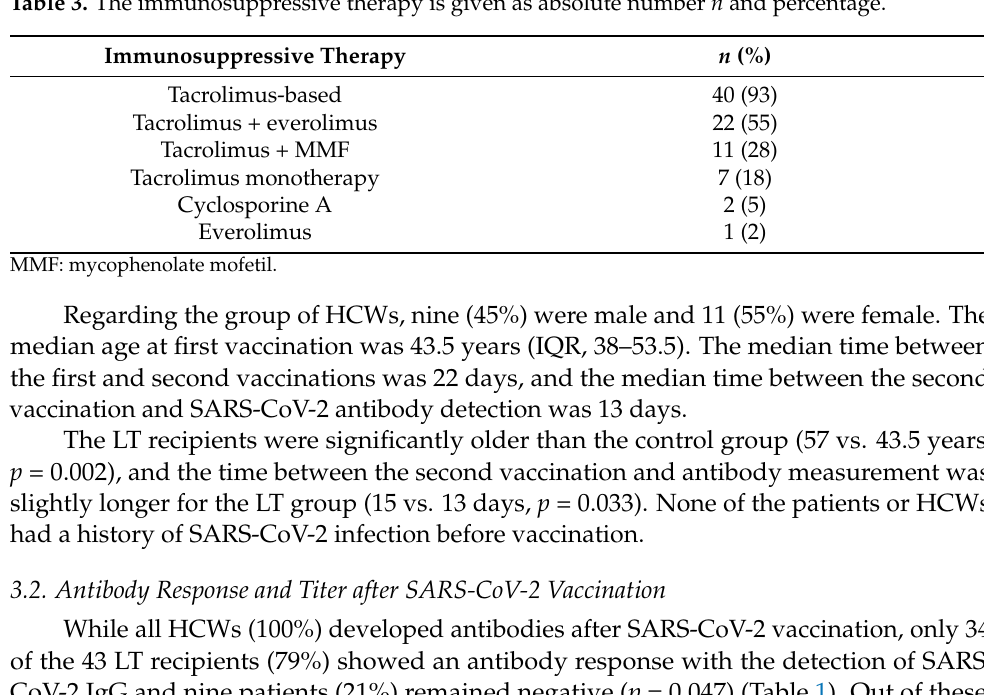
Table 3. The immunosuppressive therapy is given as absolute number n and